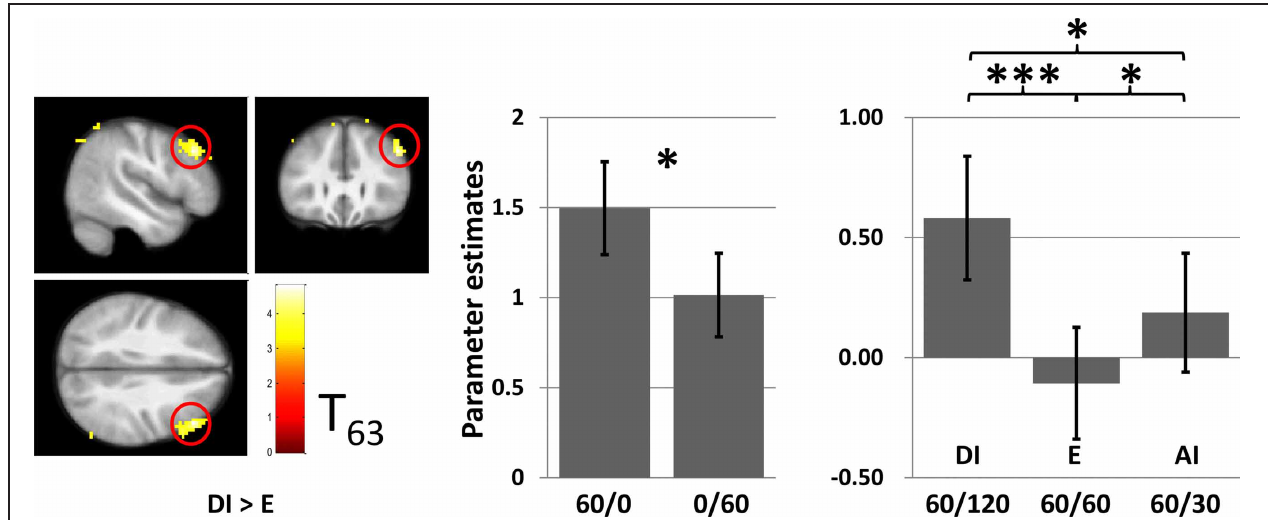
depicts effects of the different conditions at the peak voxel (plus surrounding 5mm). Note that this diagram only serves demonstration reasons. Error bars indicate standard error of means and are not informative with regard to (within-subjects) statistical inference.